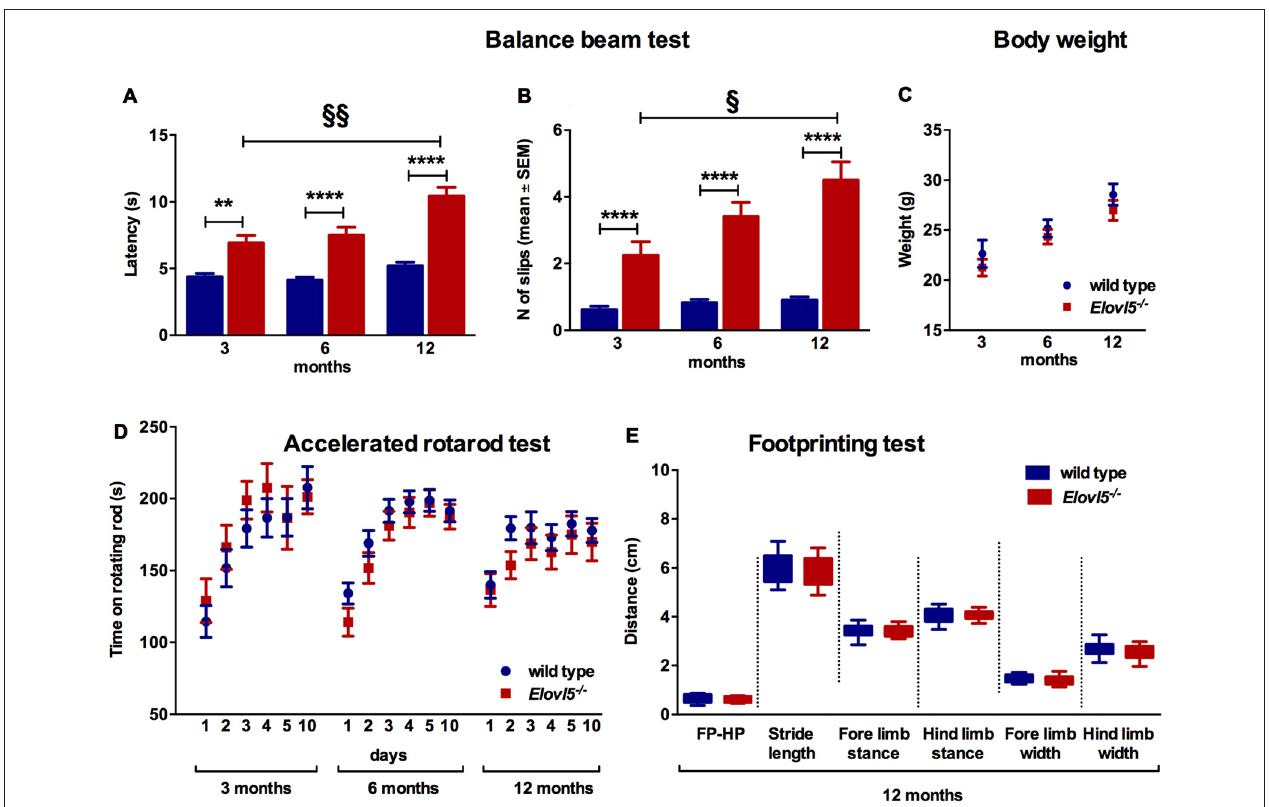
FIGURE 2 | Impaired motor control in Elovl5 − / − mice (A) Increased latency to cross the beam for Elovl5 − / − compared to wild type mice ( ∗∗∗∗ p < 0.0001, ∗∗ p < 0.01, t -test). (B) Increased mean number of foot-slips ( ∗∗∗∗ p < 0.0001). The performance of Elovl5 − / − mice worsened across months ( §§ p < 0.01, § p < 0.05, one way analyses of variance (ANOVA)). (C) Comparable body weight between genotypes at all time points analyzed ( p > 0.05, two way ANOVA). (D) The accelerated rotarod test repeated at 3, 6 and 12 months revealed a normal performance of Elovl5 − / − mice ( p > 0.05, two way ANOVA). (E) The footprinting test performed at 12